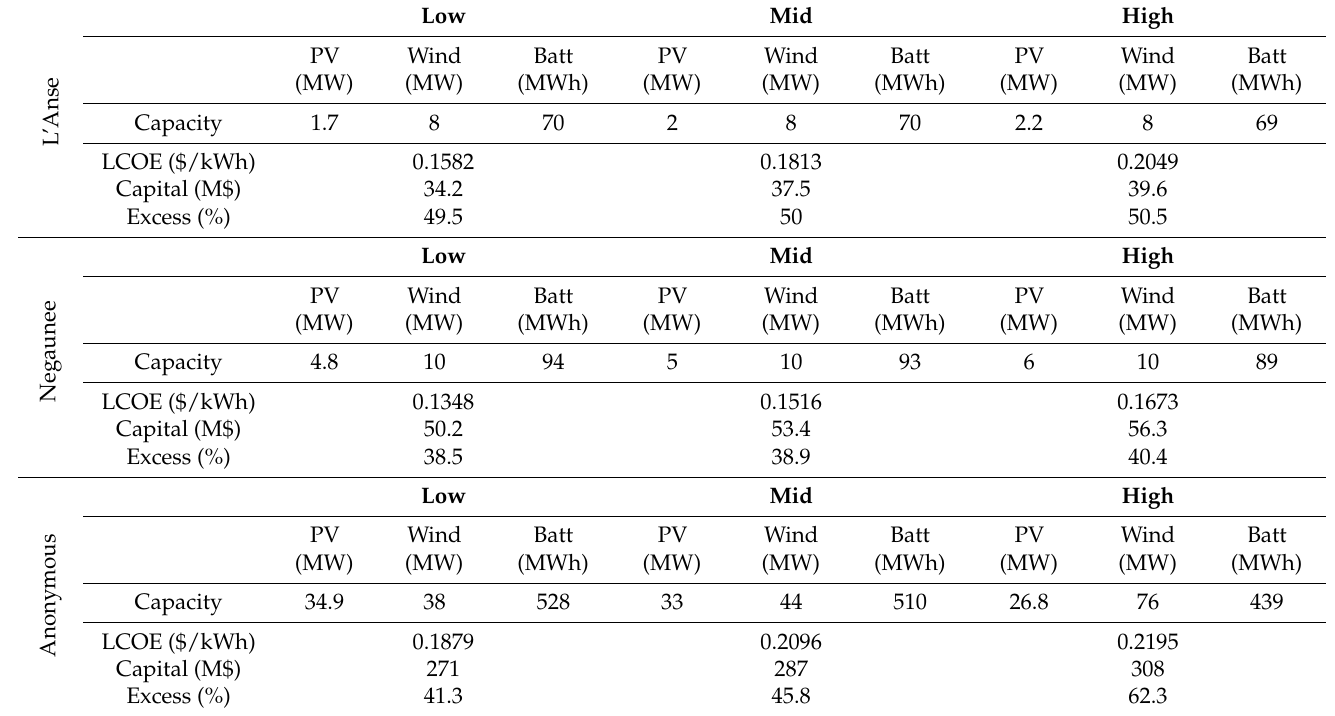
Table 6. Optimum solutions for each battery cost in the economic base